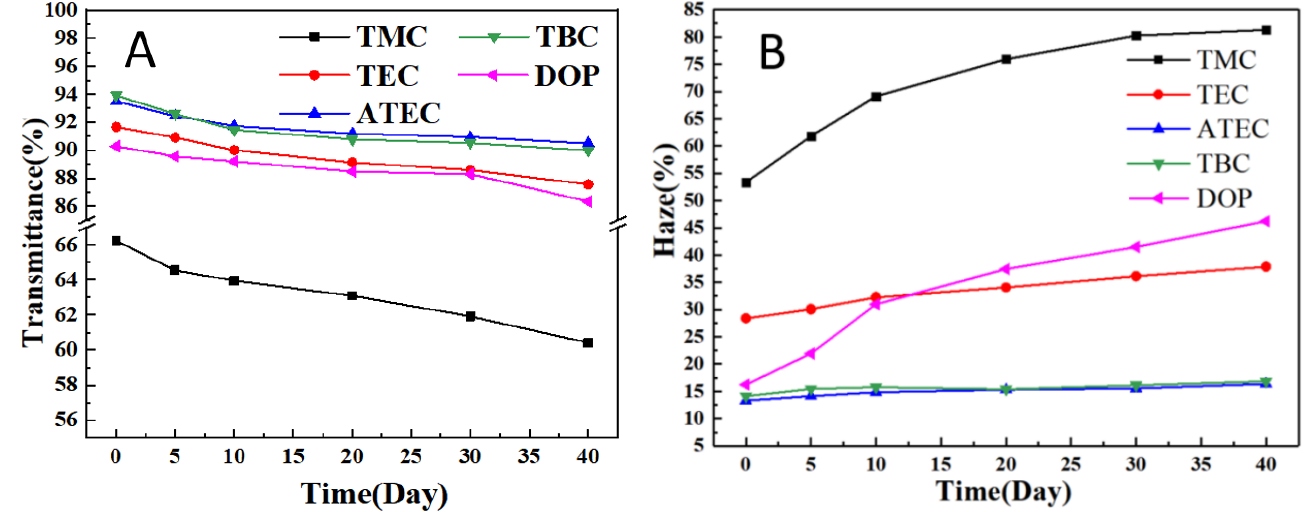
Figure 8. The average transmittance at 550–800 nm ( A ) and haze ( B ) versus time of PVC samples with Zn(Arg) 2 and different plasticizers. As shown in Figure 8A, the transmittance of the two PVC samples with ATEC and TBC maintained a good transmittance (over 90%) for 40 days, which have the highest transmittance and a small decrease in transmittance, better than that of PVC with